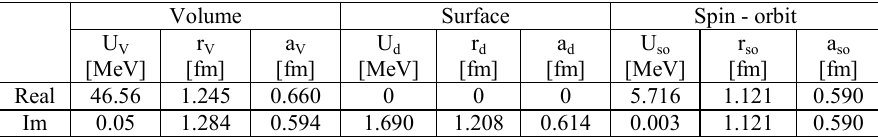
Table 2. Optical Wood-Saxon potential parameters. Central. Surface. Spin-orbit Volume